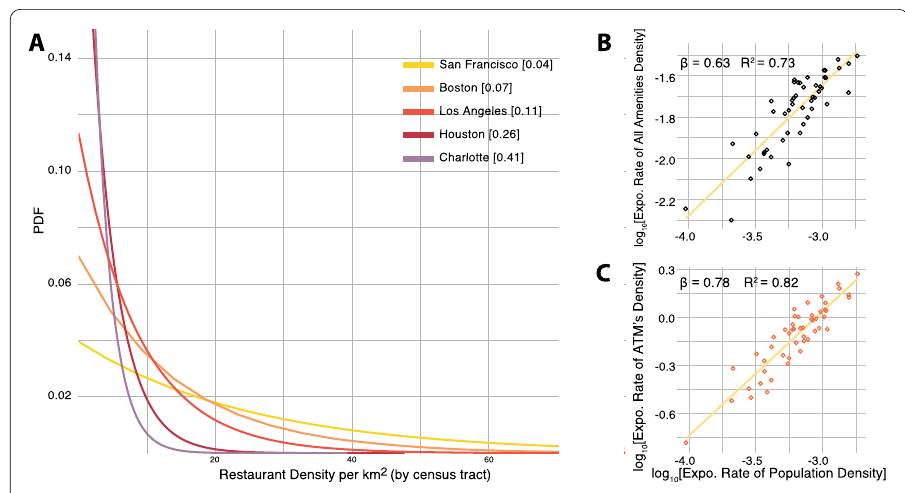
Figure 2 Spatialdistributionofamenities,bycensustracts . ( A ) The fitted exponential distribution of restaurants (by census tract). The steeper the rate of decay (Charlotte), the more unevenly restaurants are distributed. Lower rates of decay (San Francisco) mean a more even distribution of restaurants. A comparison of the fitted and actual distributions are provided in Additional file 1, Figure S1. ( B ) The exponential rate of decay for population density ( x -axis) and the exponential rate of decay for amenity density in a city ( y -axis) show a good fit on a double logarithmic scale ( R 2 = 0.73). ( C ) The same is true for a single amenity type such as ATMs ( R 2 =